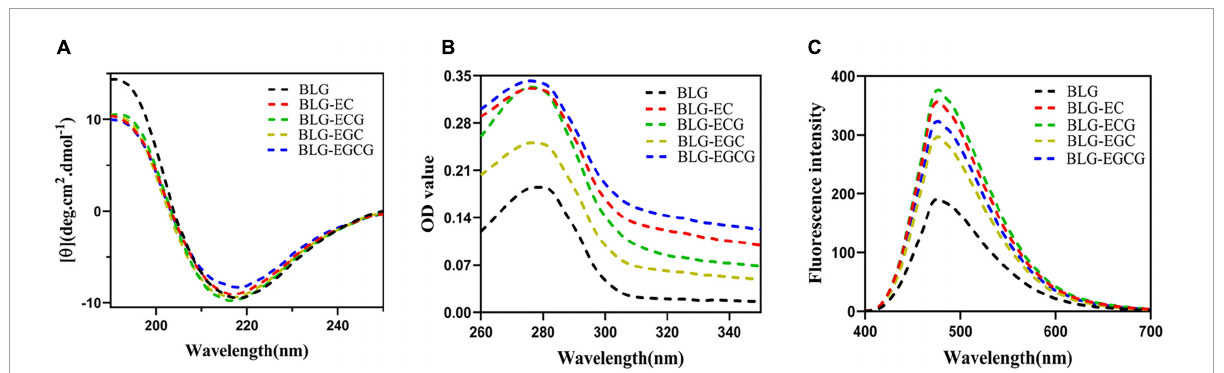
FIGURE2 Spectrum change of BLG after binding to catechin panel (A) represented the Far-UV circular dichroic spectra of BLG-catechin complexes; panel (B) represented UV-Vis spectra of BLG-catechin complexes; panel (C) represented Acid and 8-Anilino-1-naphthalenesulfonic acid (ANS) fluorescence spectra of BLG-catechin